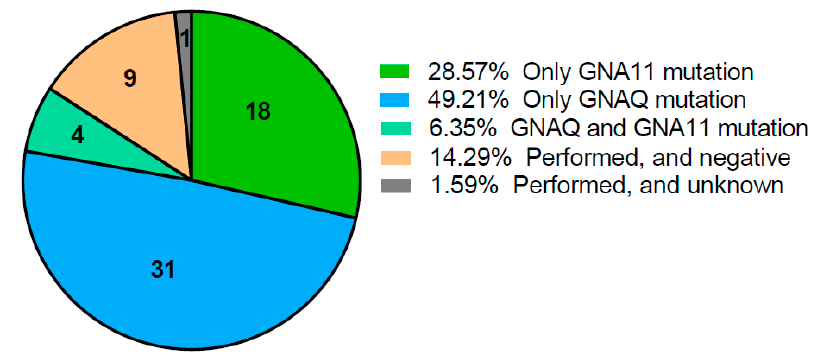
Figure 3. Results of molecular analysis of GNAQ/GNA11 mutation. Analysis was performed in 63 of 175 patients (36%).